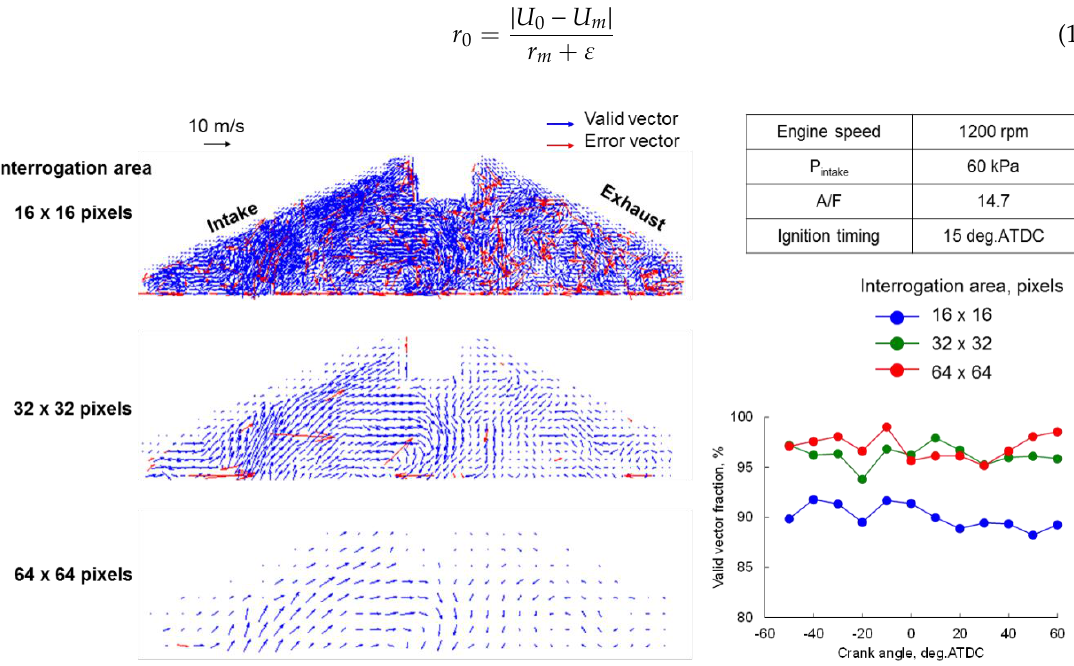
Figure 5. Validity of in-cylinder flow-field vectors from PIV processing with different interrogation areas: 16 × 16, 32 × 32, and 64 × 64 with images on left side and valid vectors % plot on the right side.